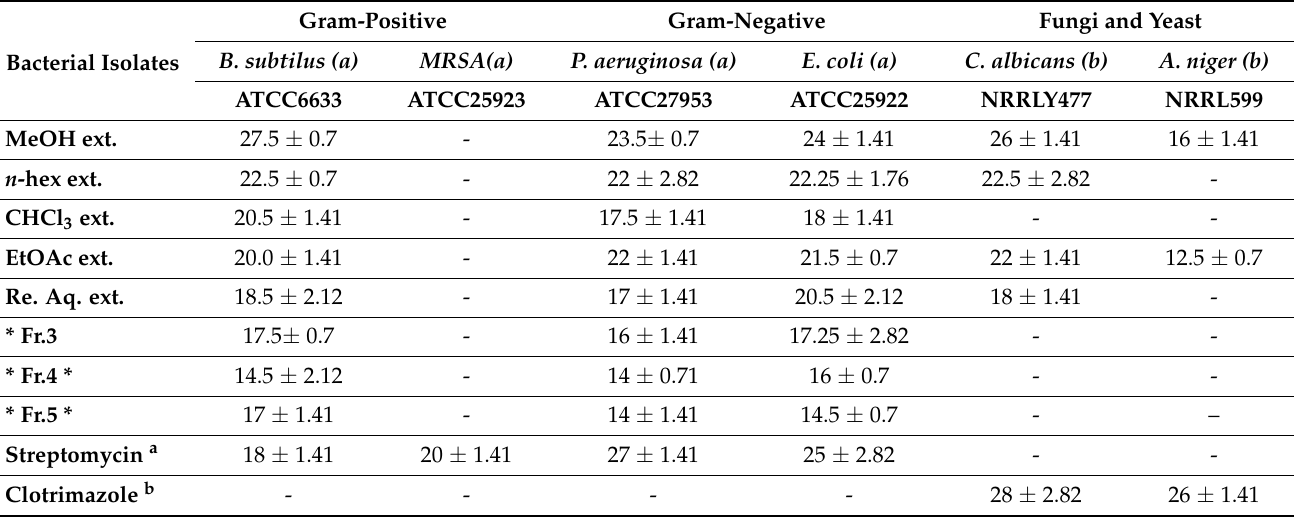
Table 4. Antimicrobial activity of the extracts and selected fractions of E. erinaceus against a selected group of bacterial and fungal